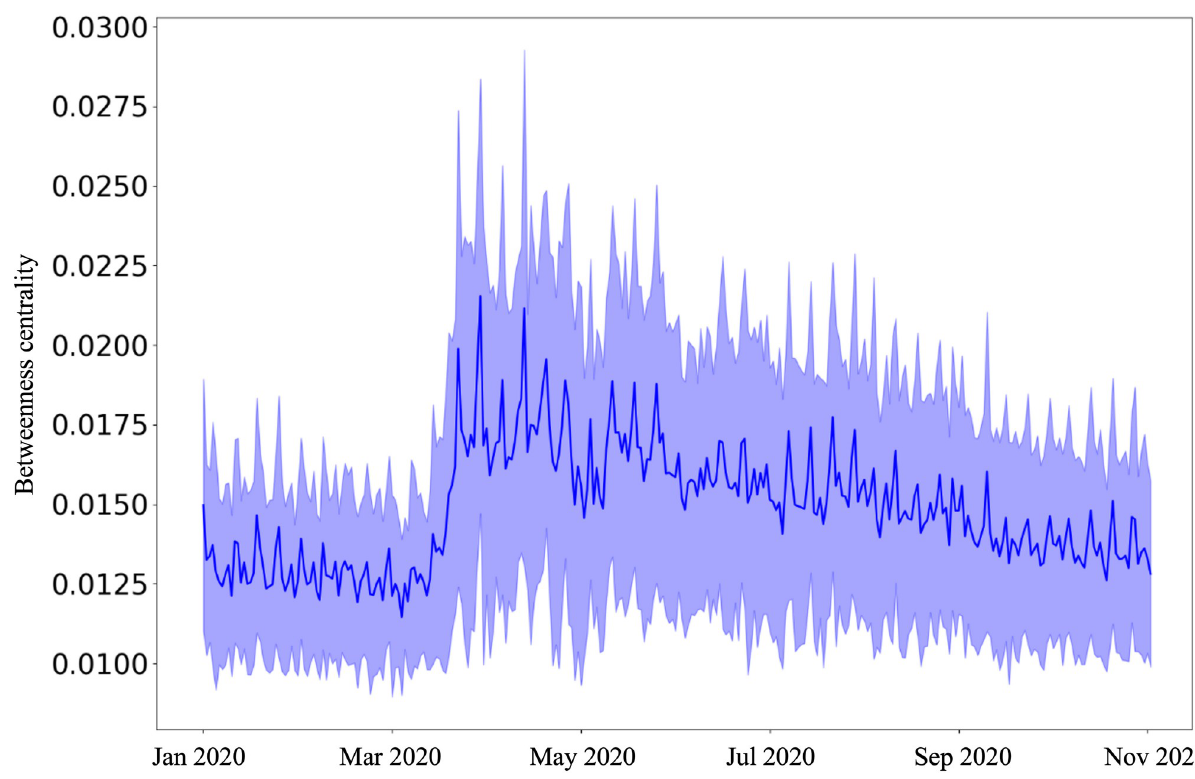
Fig 3. The weighted betweenness centrality increases and attains a peak about May 01, 2020, and steadily decreases ever